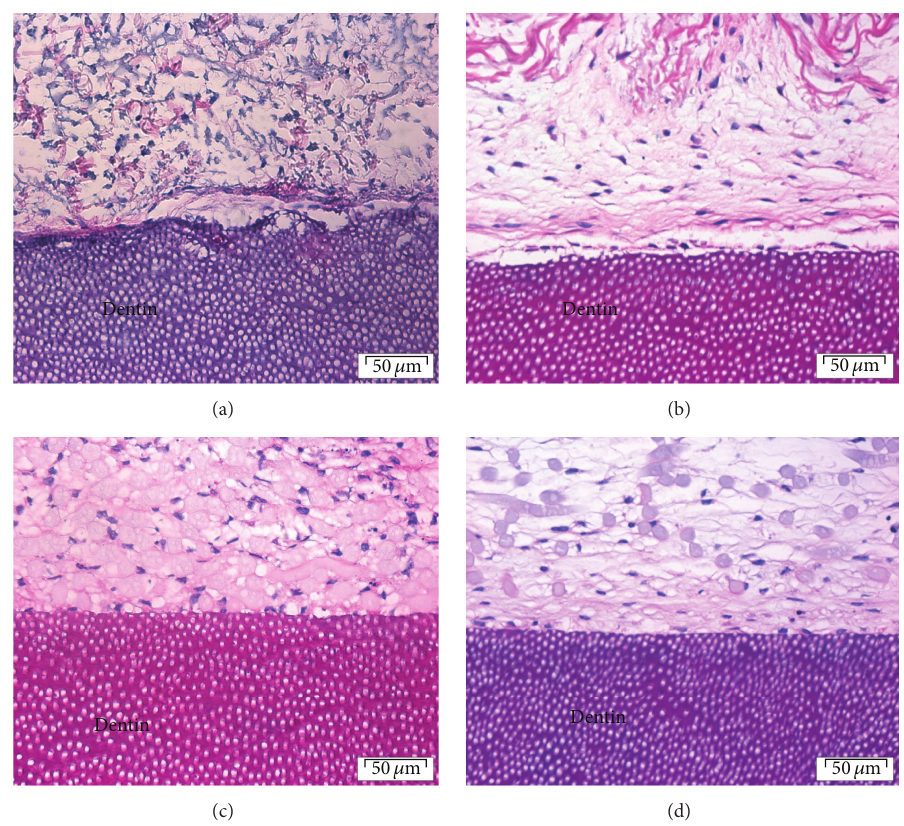
Figure 2: Histological sections of (a) collagen-spheroids-dentin, (b) collagen monolayer fibroblast-dentin, (c) PGA-spheroid-dentin, and (d) PGA-monolayer fibroblast-dentin cultures after 20 days. Hematoxylin and eosin, original magnification × 40 (scale bar = 50 𝜇